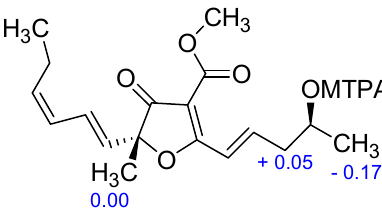
Figure 4. ∆ δ SR values (ppm) for the C-4 (cid:48)(cid:48) MTPA esters of Compound 4 Figure 4. Δ δ SR values (ppm) for the C-4 ′′ MTPA esters of Compound 4